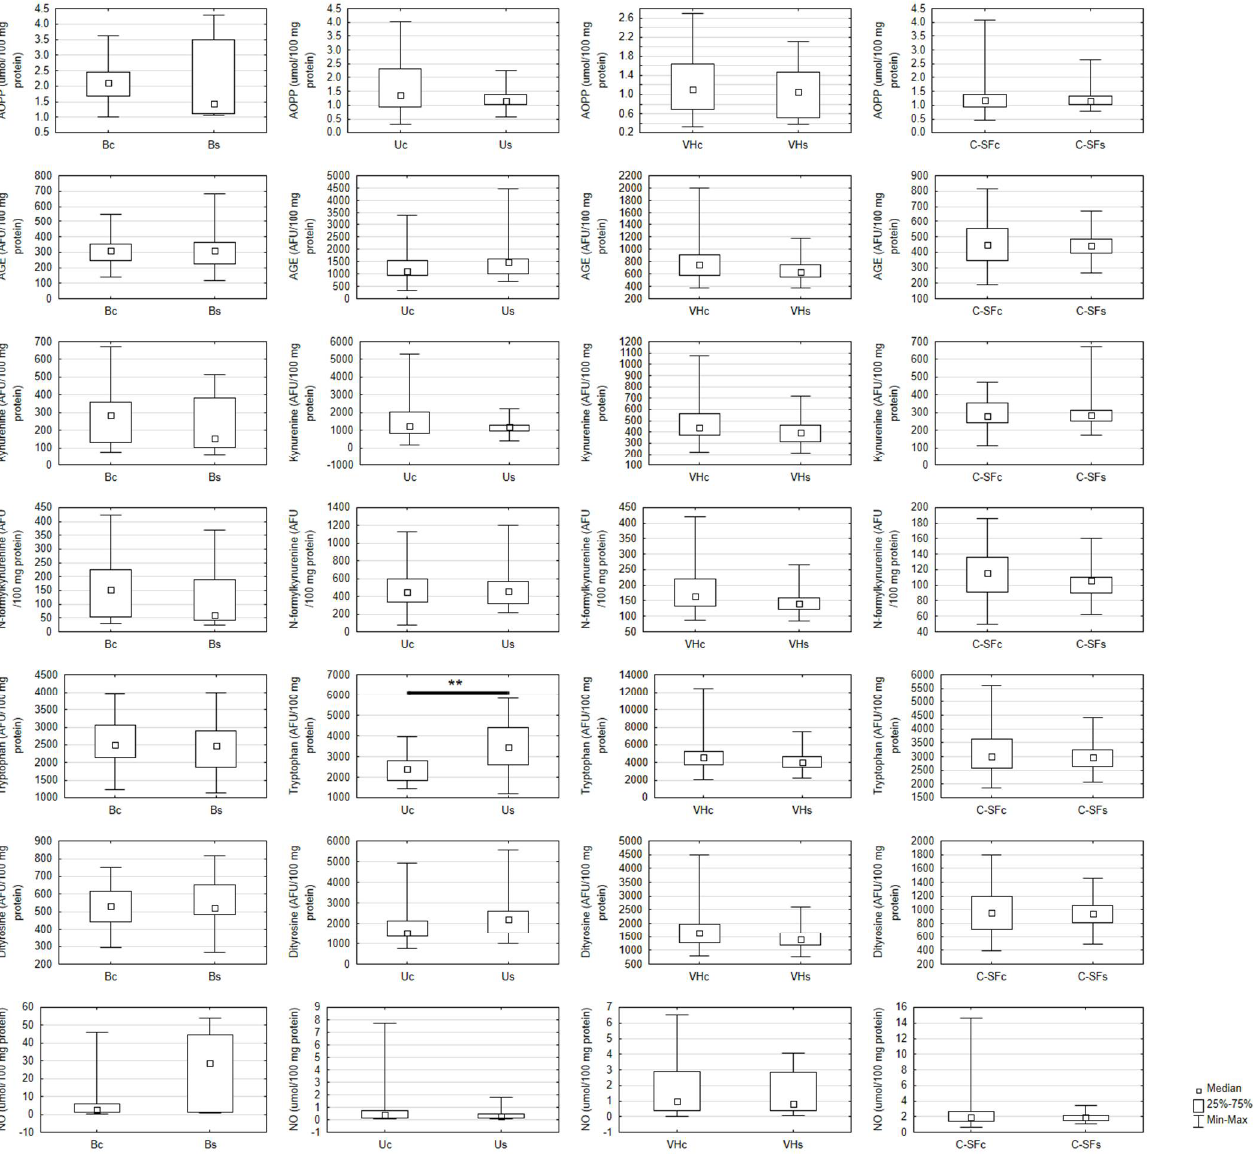
Figure 3. Oxidative damage and nitric oxide assays in the control and the study group in biological fluids. AGE, advanced glycation end products level; AOPP, advanced oxidation protein products level; Bc, blood of the control group; Bs, blood of the study group; C-SFc, cerebrospinal fluid in the control group; C-SFs, cerebrospinal fluid in the study group; NO, nitric oxide level; Uc, urine of the control group; Us, urine of the study group; VHc, vitreous humor of the control group; VHs, vitreous humor of the study group ; ** p < 0.01 vs. control.